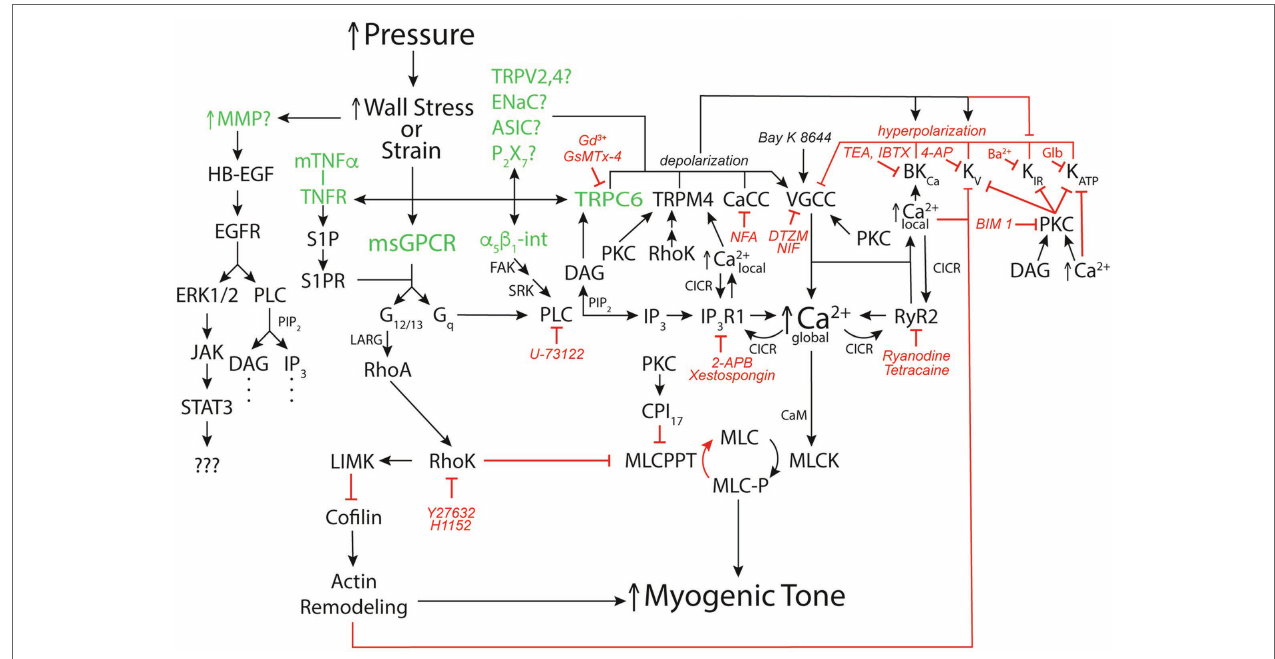
FIGURE 2 | Signaling pathways for pressure-induced myogenic tone. Schematic diagram of reported signaling pathways involved in myogenic tone in resistance arteries and arterioles. Green font color depicts putative mechanosensors in pressure-induced myogenic tone. Black arrows show stimulation, increases or activation of signaling molecules, ion channels, or enzymes that participate in myogenic tone. Red capped lines indicate inhibition, decreases or deactivation of signaling molecules, ion channels, or enzymes involved in myogenic tone. Also shown are pharmacological agents that we have used to interrogate the ion channels and signaling pathways in arteriolar myogenic tone. MMP, matrix metalloproteinase; HB-EGF, heparin-bound epidermal growth factor; EGFR, epidermal growth factor receptor; ERK1/2, extracellular-signal-related kinases 1 or 2; JAK, janus kinase; STAT3, signal transducer and activator of transcription 3; mTNF α , membrane- bound tumor necrosis factor α ; TNFR, TNF α Receptor; S1P, sphingosine-1-phosphate; S1PR, S1P receptor; α 5 β 1 -int, α 5 β 1 integrin: FAK, focal adhesion kinase; SRK, Src-related kinases; CaCC, Ca 2+ -activated Cl − channel; TRPV2,4, transient receptor potential vanilloid-family 2 or 4 channels; ENaC, epithelial Na + channel; ASIC, acid sensing ion channel; P 2 X 7 , P 2 X 7 purinergic receptor; VGCC, voltage-gated Ca 2+ channel; BK Ca , large-conductance Ca 2+ -activated K + channel; K V , voltage-gated K + channel; K IR , inwardly-rectifying K + channel; K ATP , ATP-sensitive K + channel; msGPCR, mechanosensitive G-protein-coupled receptor; DAG, diacylglycerol; PKC, protein kinase C; NFA, niflumic acid; DTZM, diltiazem; NIF, nifedipine; TEA, tetraethylammonium; IBTX, iberiotoxin; 4-AP, 4-aminopyridine; GLIB, glibenclamide;